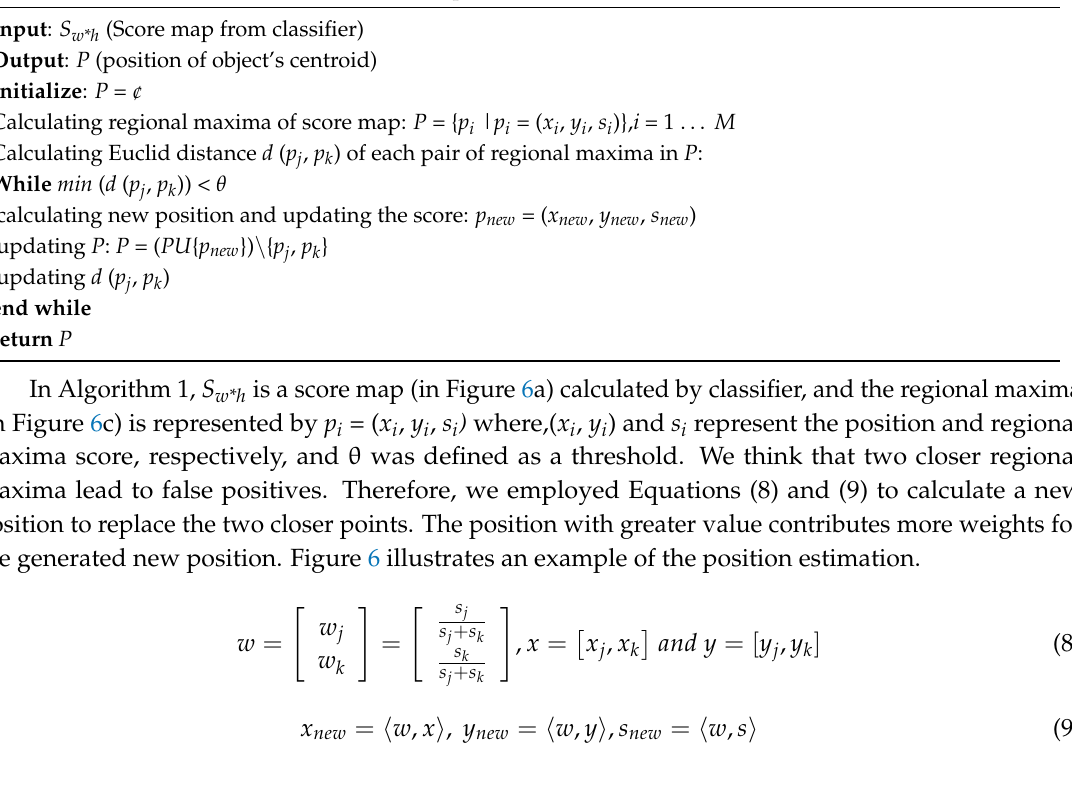
Algorithm 1 . Position estimation for a score map (from the